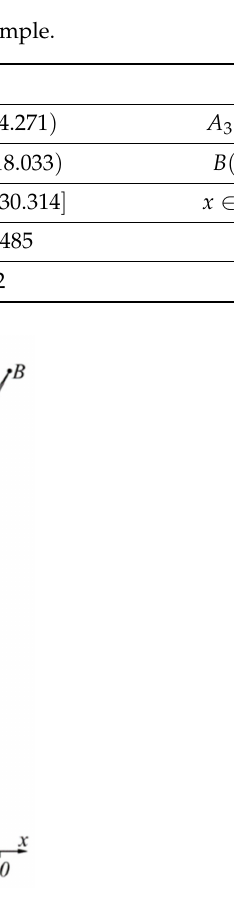
Figure 5. Graphical results of the solution of the illustrative